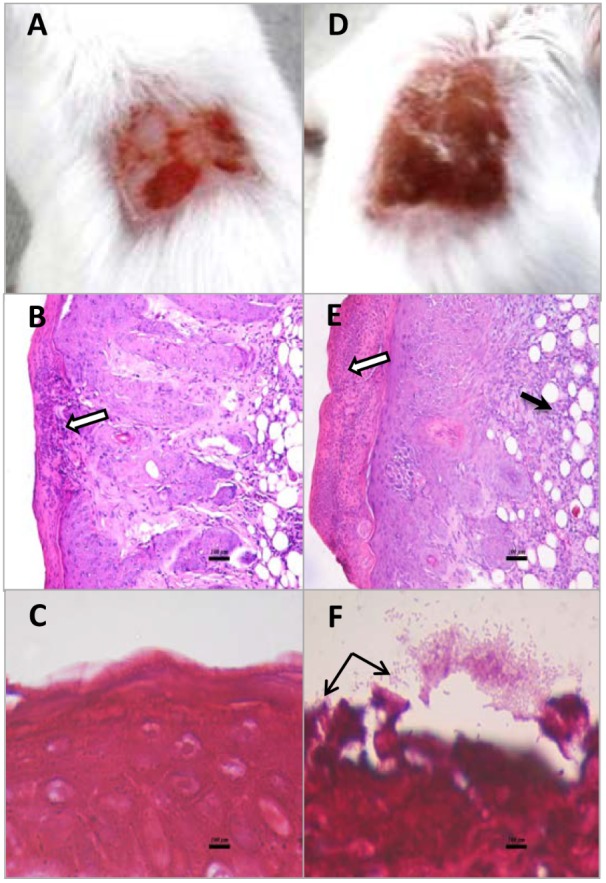
Macroscopic and histopathological appearance of wounds from non-infected mice and mice infected with S. aureus ATCC43300 (MRSA). Wounds of non-infected and infected sham-treated mice were observed and photographed at 4d PI (A,D). Tissue samples were removed, fixed, embedded sectioned, and mounted. Sections were stained with hematoxylin/eosin to observe tissue structure (B,E) or with crystal violet (C,F) to observe bacterial cells. Hypodermal necrosis (white arrows) was infrequent and only focal in nature in control non-infected mice (B) but was always present and generally extensive in infected mice (E). Infected mice also exhibited infiltration of mononuclear cells (black arrow in E). CV staining showed bacterial cells (black arrows) in and around the necrotic epidermis only in infected mice (F).